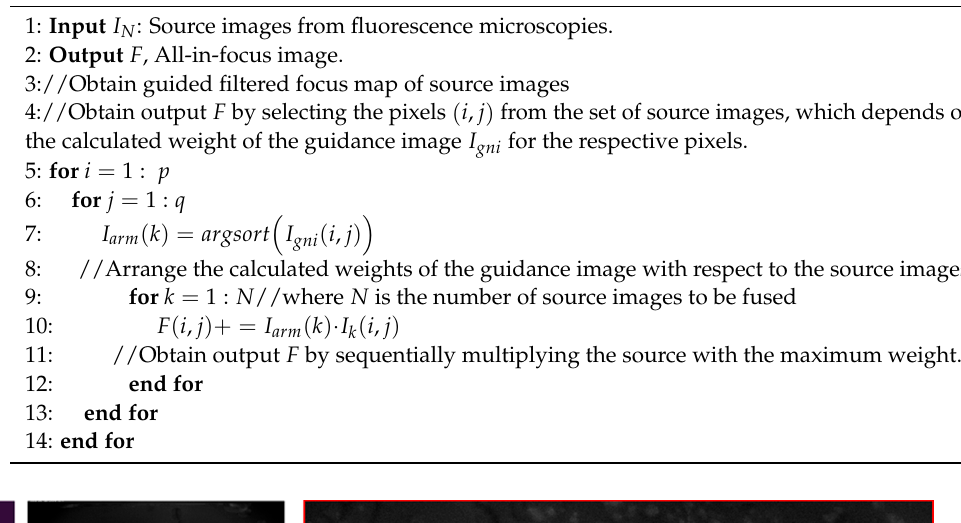
Algorithm 1 Multi-focus image fusion algorithm.